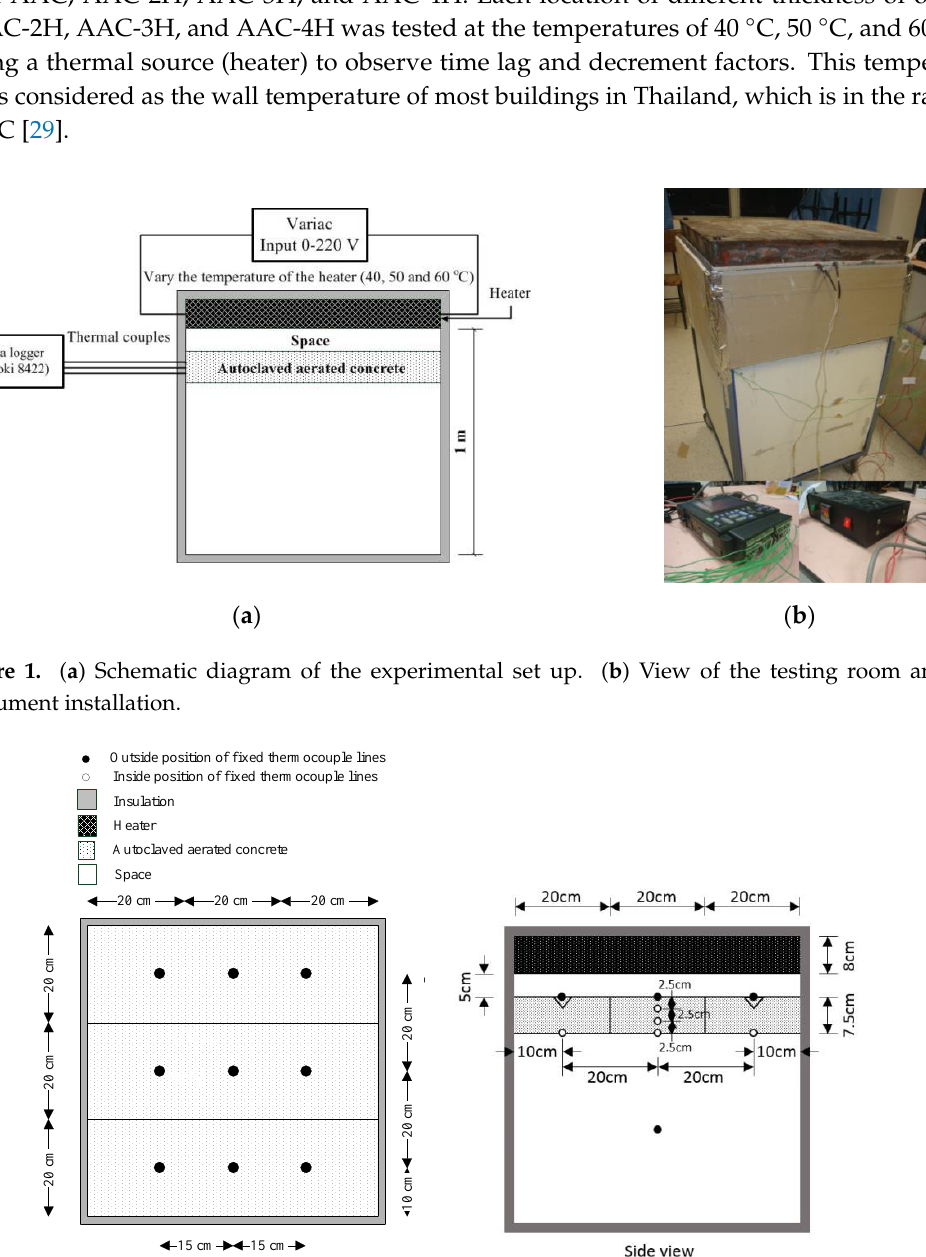
Figure 3. View of the testing rooms with different conical holes in real weather. 3. Results 3.1. Phase Change Material Behavior The endothermic and exothermic peaks of phase change material as paraffin are shown in Figure 4. Temperature range from 0 °C to 90 °C was considered to investigate the melting and solidification point of paraffin. There are two endothermic peaks distinctively appeared in the temperature range of 0 °C to 90 °C. The first small endothermic peak was presented at approximately 41.5 °C with an involved enthalpy of 22.13 J/g, which is related to the starting state of paraffin melting. Next, there was an increase in temperature to 90 °C, a second broadening endothermic peak with an enthalpy of 137.67 J/g around 59 °C that was related to the process of the molten paraffin and continued from the first endothermic peak. Moreover, the two exothermic peaks were observed at approximately 58.5 °C and 40 °C when the temperature dropped from 90 °C to 0 °C. The first exothermic peak showed the enthalpy of 131.35 J/g because of the solidification process of some contents of paraffin. The enthalpy of 11.25 J/g was observed in the second small exothermic peak, which was related to the solidification due to heat discharge. This indicated that the condition of temperature range for the melting point, solidification point, and thermal storage capacity of paraffin PCM was suitable for the PCM integration investigation into autoclaved aerated concrete.